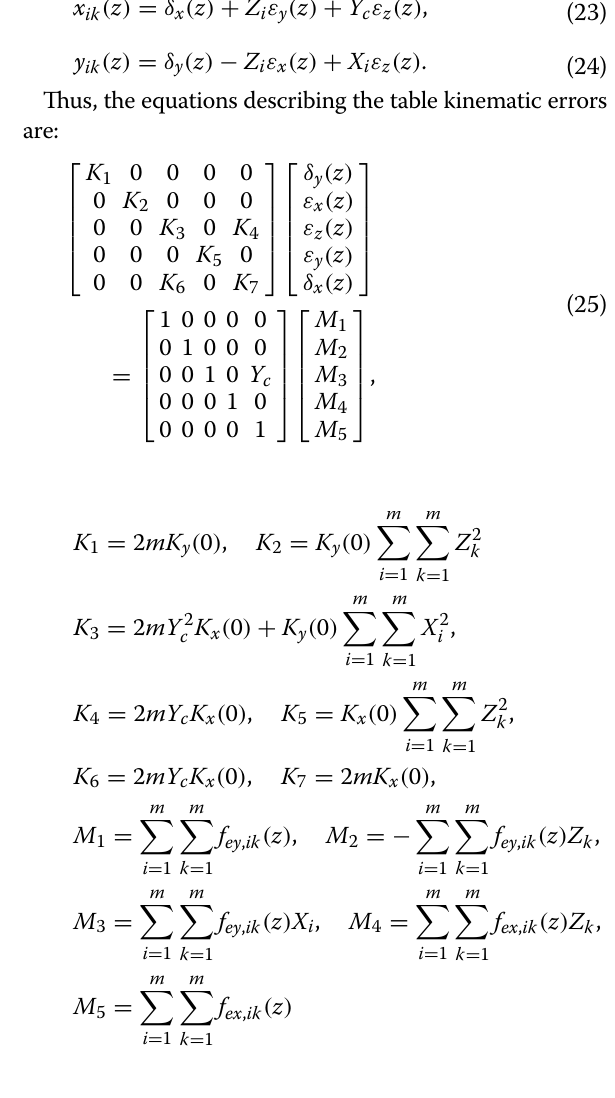
The table kinematic errors ( δ x ( z ), δ y ( z ), ε x ( z ), ε y ( z ),